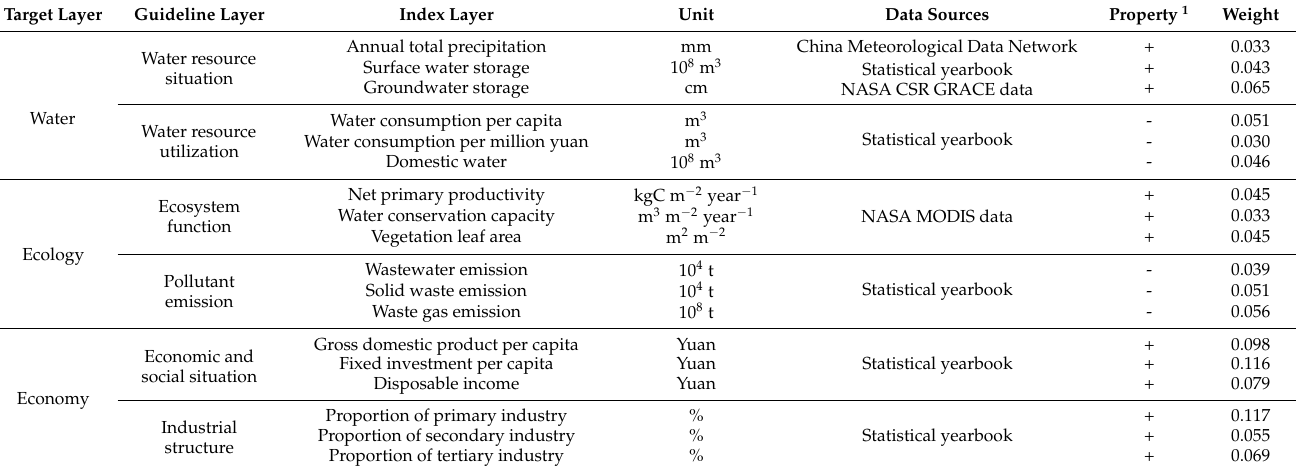
Table 1. Evaluation index system of the water–ecology–economy coupling coordination relationship in the Wuding River